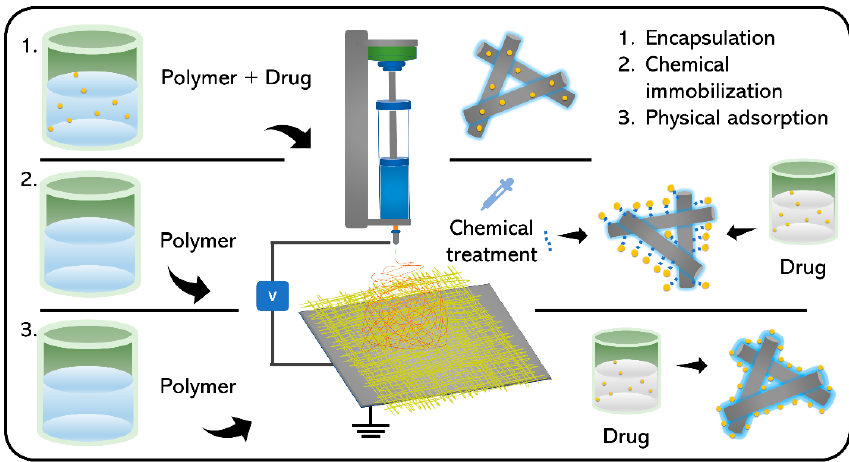
Figure 6. Schematic of various methods of drug loading.